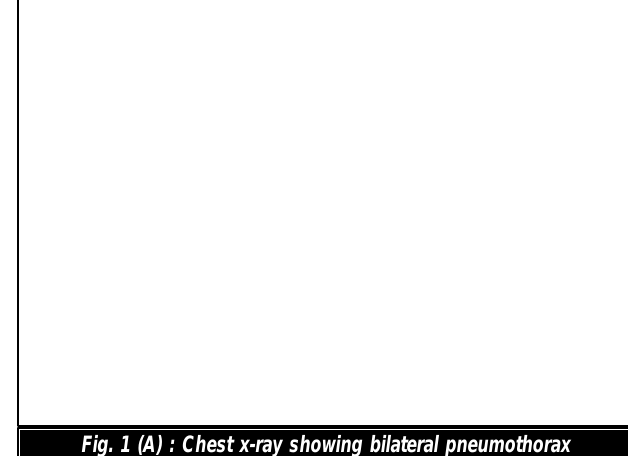
Fig. 1 (A) : Chest x-ray showing bilateral pneumothorax with multiple emphysematous